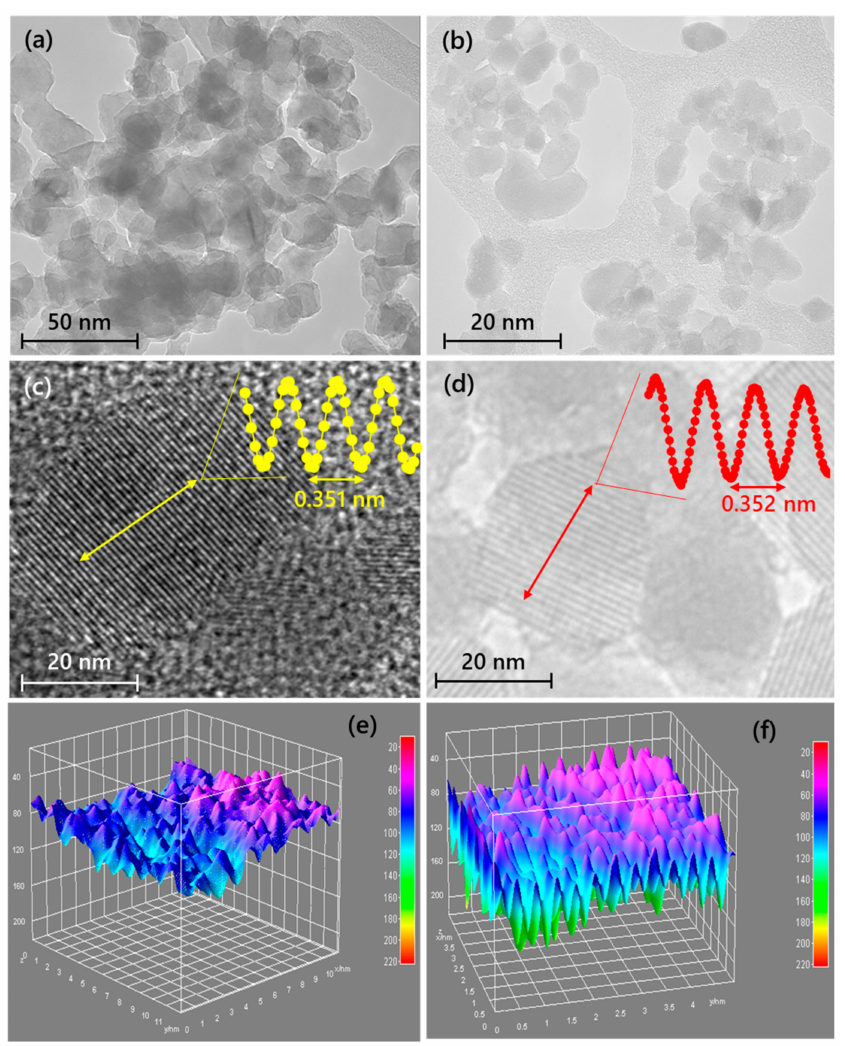
Figure 4. TEM images of ( a ) CB-TiO 2 , ( b ) CNB-TiO 2 , HRTEM images of ( c ) CB-TiO 2 , ( d ) CNB-TiO 2 , and 3D view surface plots of ( e ) CB-TiO 2 , and ( f ) CNB-TiO 2 . Inset of ( c , d ) are the corresponding line profiles CB-TiO 2 and CNB-TiO 2 ,